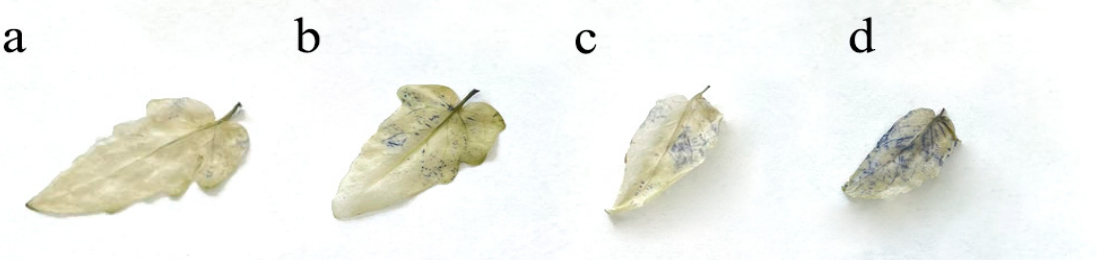
Figure 3. Histochemical determination of superoxide in leaves: ( a ) control; ( b ) 20 MPC BaP; ( c ) 40 MPC BaP; ( d ) 60 MPC BaP.